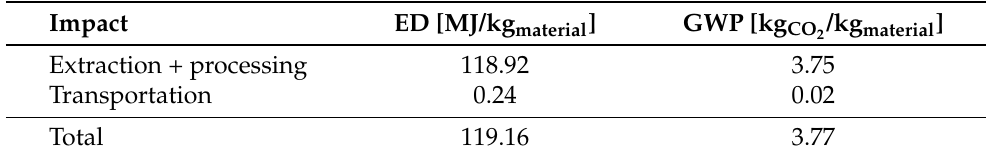
Table 10. Average ED and GWP related to the extraction, processing, and transportation for the silicone rubber tube of the BP liquid cooling system.